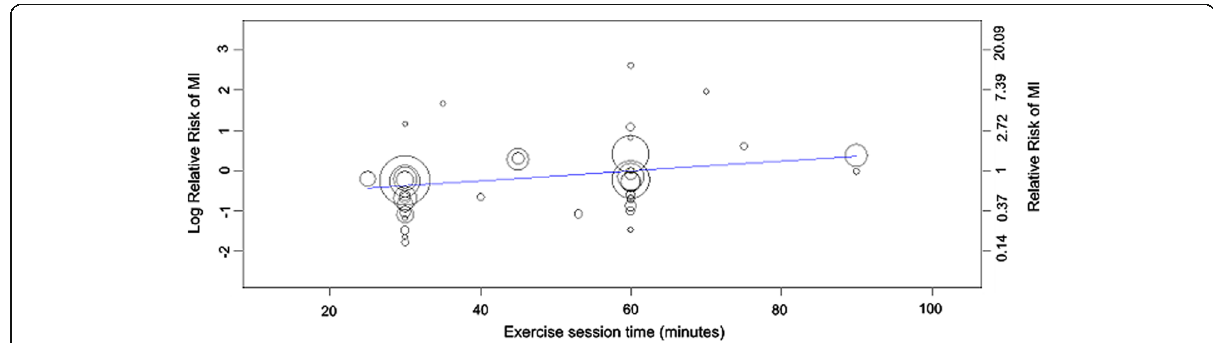
Fig. 5 Relationship between the prescribed time for exercise training each session and the relative risk of myocardial infarction compared to usual care ( p = 0.011). Each intervention is represented by a circle ; the size of the circle is proportional to the number of participants undertaking that intervention. A log RR of >0 represents an increase in risk and <0 a